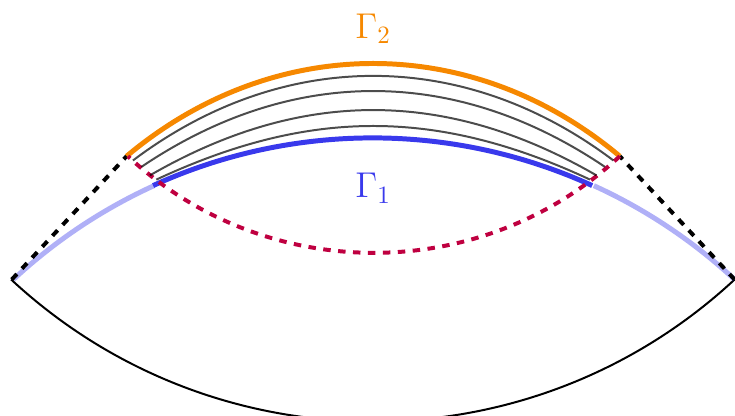
Figure 3 . A boundary-anchored extremal surface (cid:0) 1 and the corresponding cuto(cid:11)-anchored ex- tremal surface (cid:0) 2 , drawn here in a portion of a constant-time slice of vacuum AdS 3 . In order to identify these surfaces, we assume the existence of a smooth foliation of extremal surfaces, sketched here as gray curves, that interpolates between the two. Using Stokes’ theorem, we can compute the di(cid:11)erence in area between (cid:0) 1 and (cid:0) 2 by performing an integral along the intersection of this foliation with the cuto(cid:11) surface z = z c . (Cf. equation